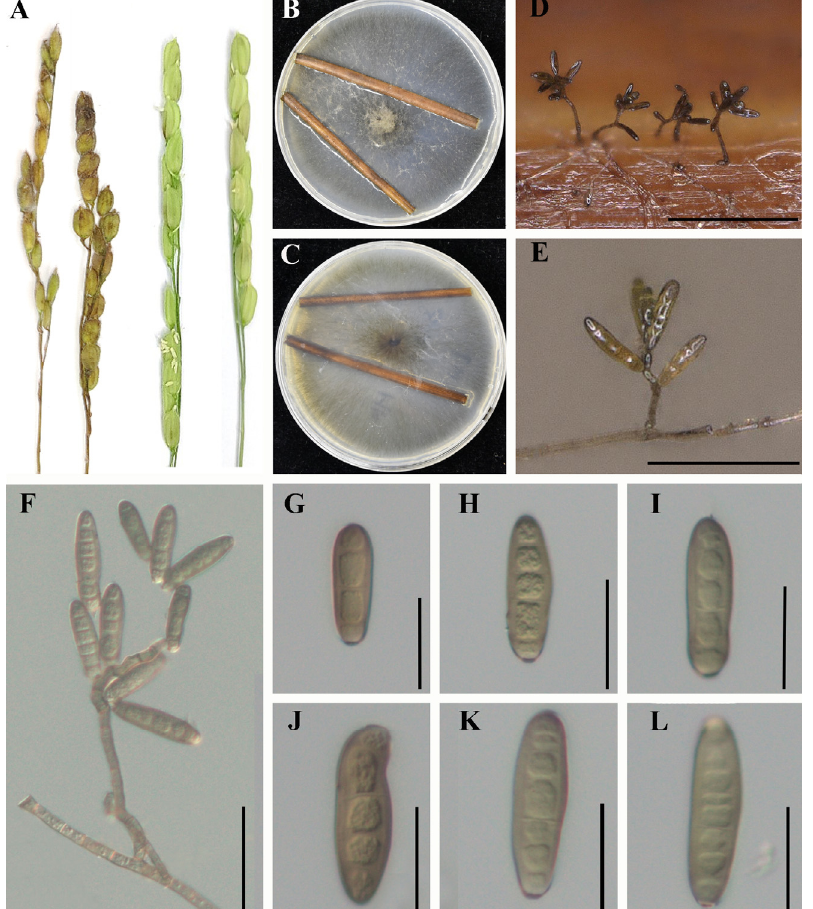
Figure 2. Morphological characteristics of B. zeicola LWII. ( A ) Disease symptoms and experimental control group of B. zeicola LWII on rice. ( B , C ) Growth of B. zeicola LWII on TWA-W agar (front and reverse). ( D , E ) Conidia produced by B. zeicola LWII on wheat straw on TWA-W agar. The ( D ) im- age bar = 200 μ m, and the ( E ) image bar = 100 μ m. ( F – L ) Conidial structure and morphology of B. zeicola LWII. The ( F ) picture bar = 50 μ m, and the ( G – L ) picture bar = 25 μ m.